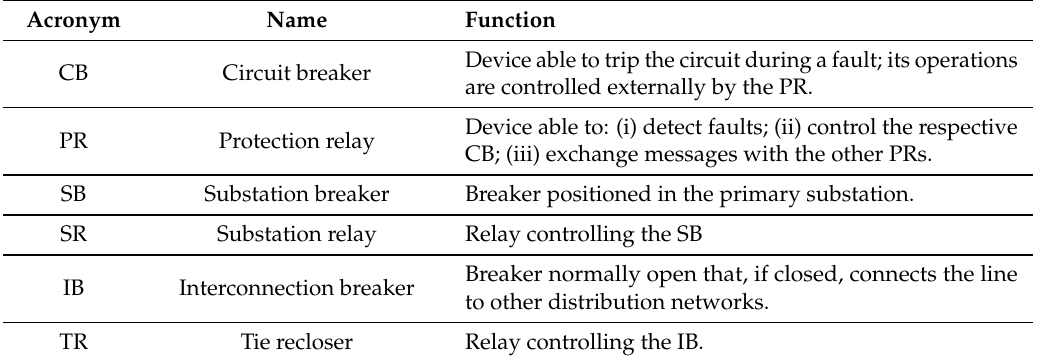
Figure 1. Example of fault management in a medium-voltage (MV) network according to the logic selectivity paradigm. ( a ) Healthy conditions. ( b ) Fault between protection relay 2 (PR2) and PR3; transmission of blind signals. ( c ) Circuit breaker 2 (CB2) tripping, and transmission of the Trip signal to PR3. ( d ) CB3 tripping and transmission of the Close signal to Tie recloser (TR). Table 1. Devices involved in logic selectivity